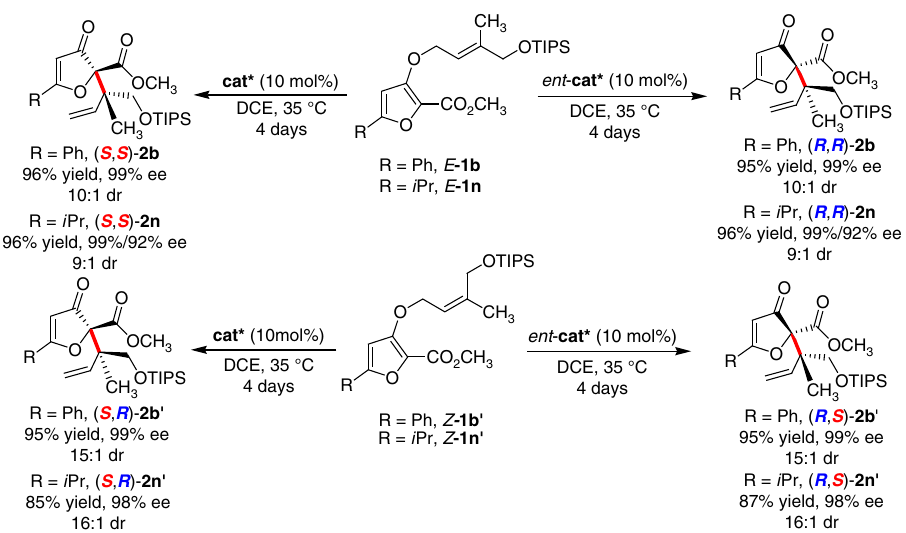
Fig. 4 Synthesis of all four stereoisomers. Unless otherwise noted, the reactions were performed with 1 (0.1 mmol), and cat* or ent -cat* (10 mol%), in DCE (1.0 mL) at 35 °C for 4 days. Isolated yield. The dr value was determined by 1 H NMR and HPLC analysis. The ee value was determined by HPLC analysis on